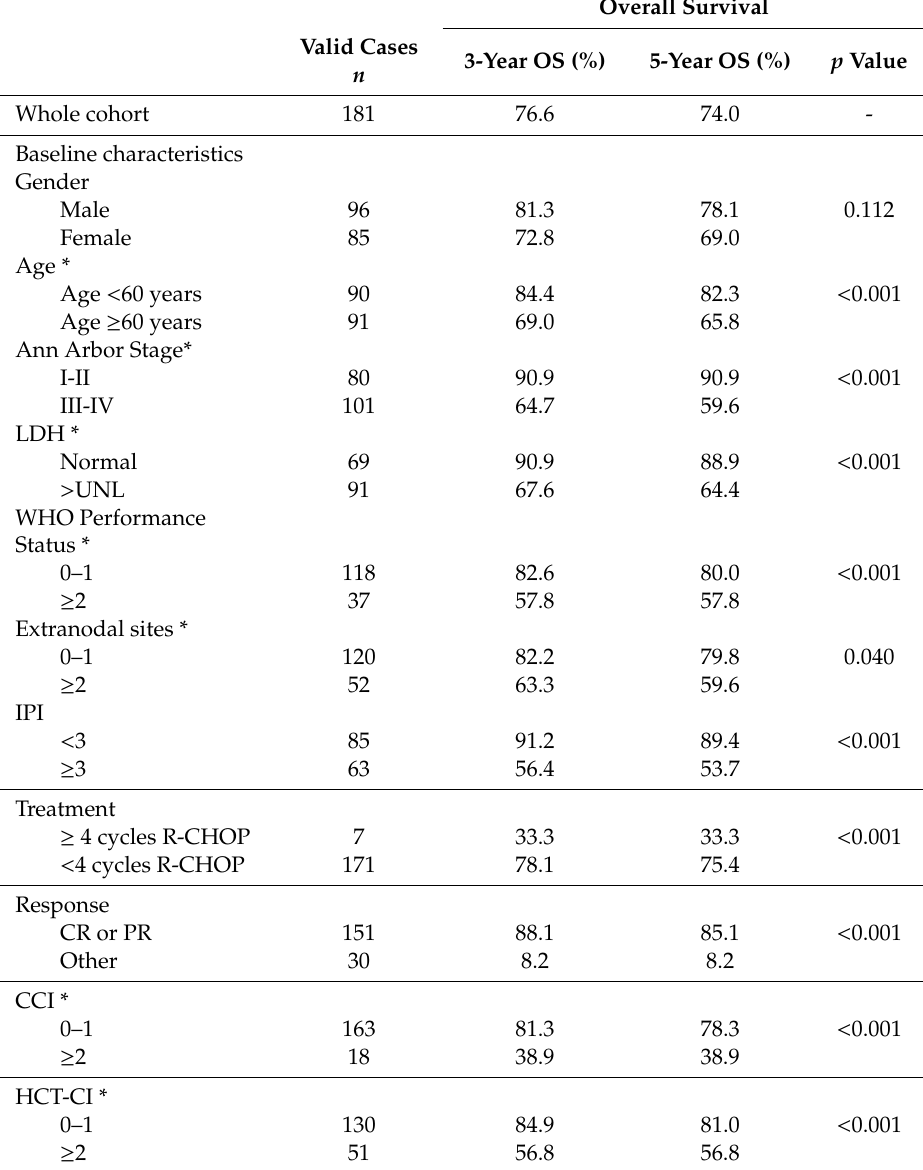
Table 4. Prognostic factors for overall survival in univariate